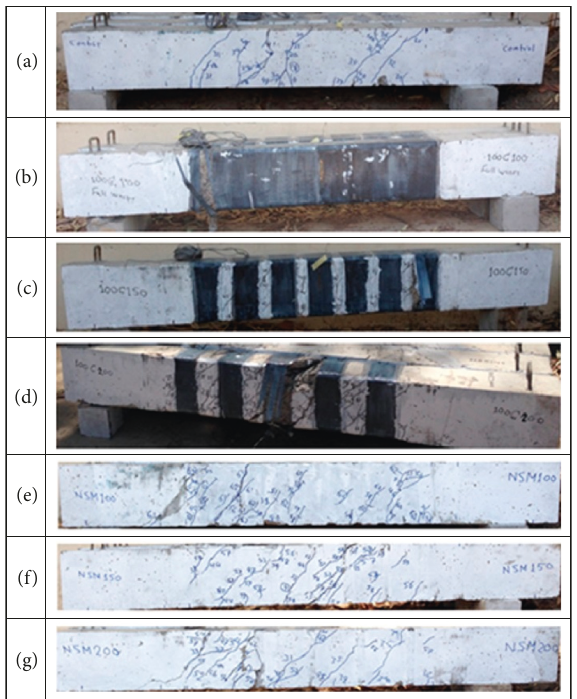
Figure 15: Mode of failure for specimens tested under combined torsion and bending. (a) Control specimen, (b) full transverse wrapping (100C100), (c) 100C150, (d) 100C200, (e) NSM100, (f) NSM150, (g)